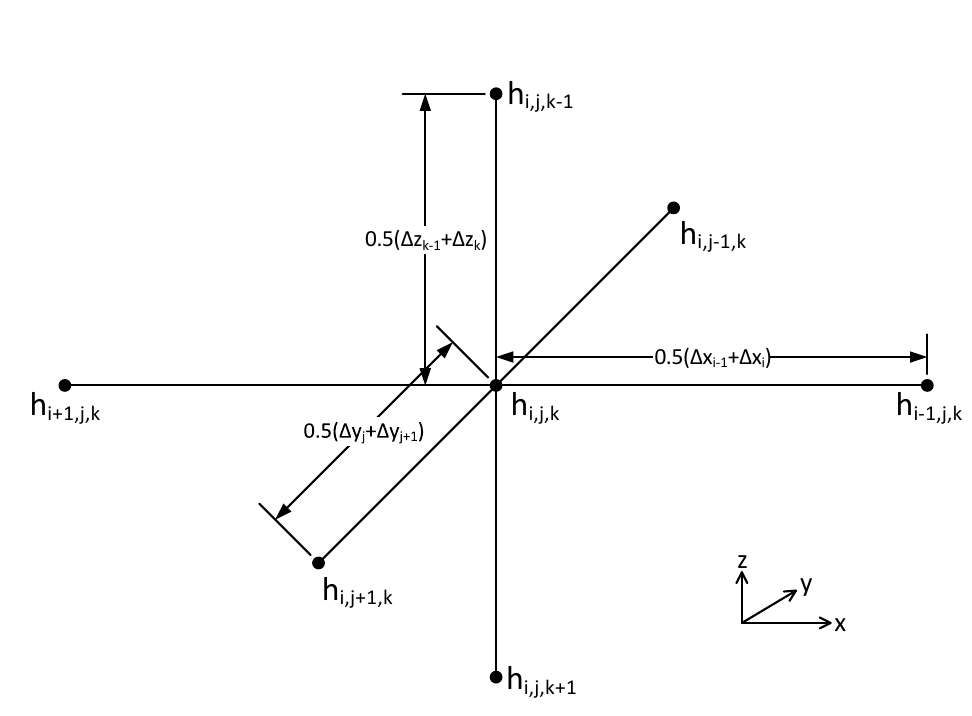
Figure 2. A diagram illustrating spatial relation between center state and neighboring